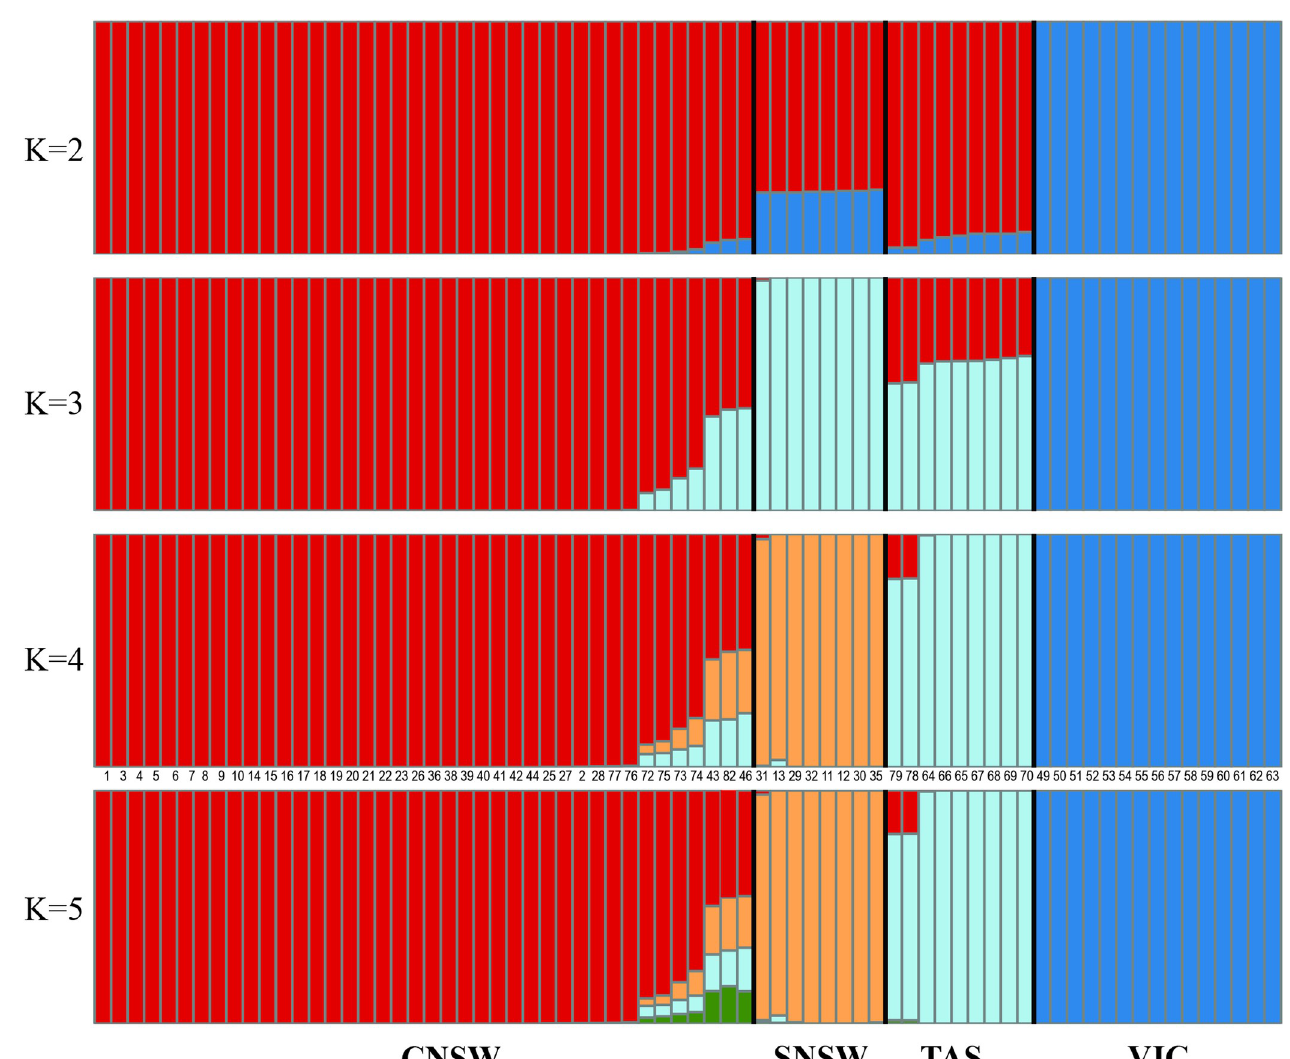
Fig 3. STRUCTURE results for P . taeniolatus from southeast Australia. Result from the Bayesian clustering algorithms of STRUCTURE v.2.3.4 [45]. Results for K 2–5 are shown. Individuals from Wollongong (N = 1) and Hobart (N = 2) were included in these analyses. The most likely K was four and represent the four distinct populations: central New South Wales (CNSW), southern New South Wales (SNSW), Tasmania (TAS), and Victoria (VIC). Numbers below K = 4 are individual seadragon sample IDs (see S1 Table, under Field ID).